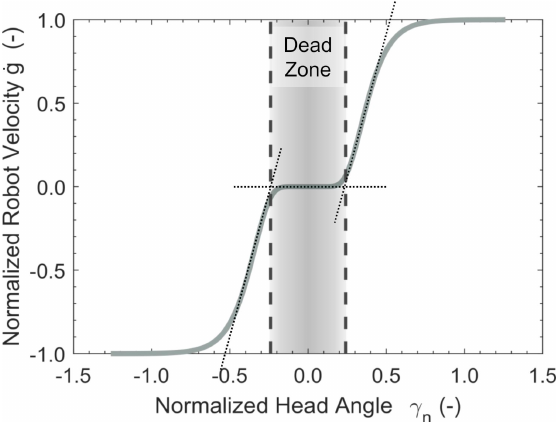
Figure 4. Robot control transfer function. A G OMPERTZ -function is used as transfer function. The used parameters are A max = 1, δ = − 30 and r = − 10. The space between the dashed lines indicates the